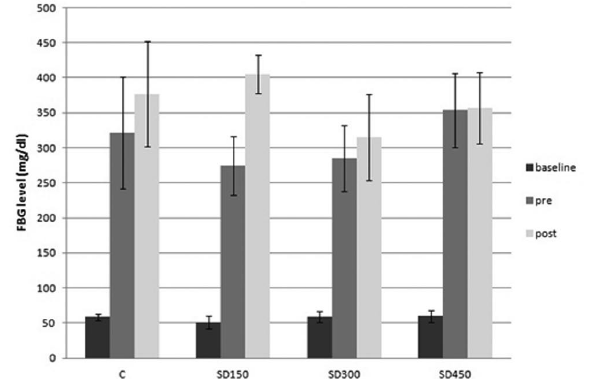
Figure 1. Fasting blood glucose levels (mg/dl). Values are expressed as mean ± SD. C, diabetic control group; SD150, diabetic group treated with 150mg/kgbw brown algae (S. duplicatum) extract; SD300, diabetic group treated with 300mg/kgbw brown algae (S. duplicatum) extract; SD450, diabetic group treated with 450mg/kgbw brown algae (S. duplicatum) extract. Baseline, fasting blood glucose levels at the beginning of the study; Pre, fasting blood glucose levels after STZ induction/before treatment; Post, fasting blood glucose levels after treatment.